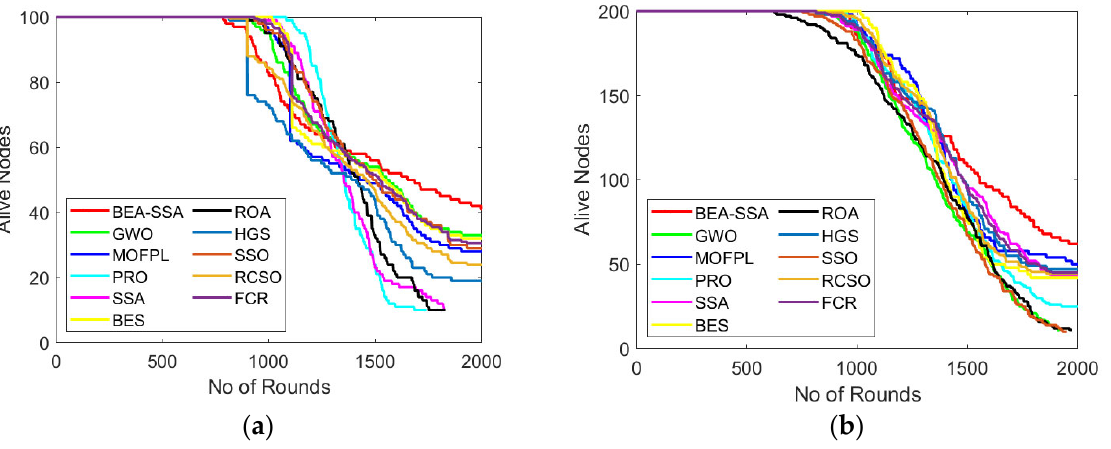
Figure 6. Alive node analysis using BEA ‐ SSA compared with the other models [20–22,26] for node counts of ( a ) 100 and ( b ) 200.